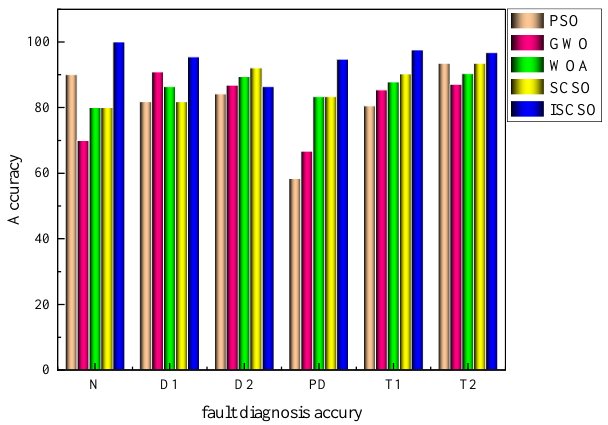
Figure 22. Various fault accuracy diagrams of BiGRU model.